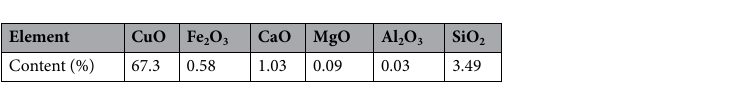
Figure 6. XRD pattern of the original malachite.